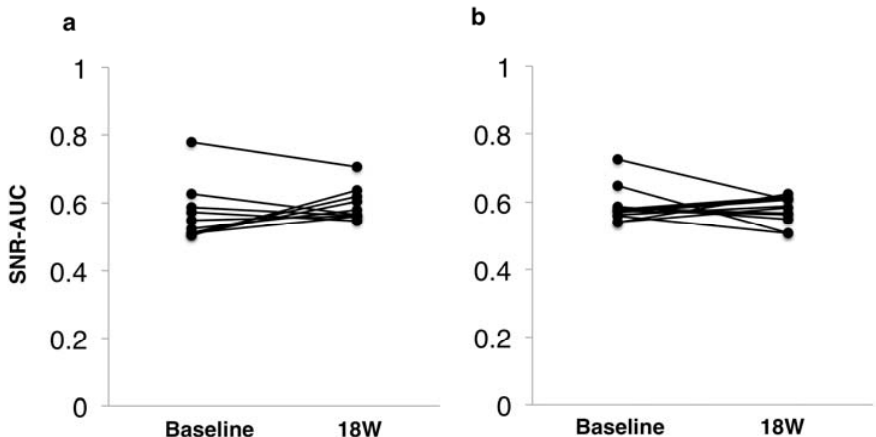
Figure 6. ROC analysis for multifocal visual evoked potentials from baseline to eight weeks after SES: ( a ) all 60 sectors showed no significant difference in SNR ‐ AUC ( p = 0.33); and ( b ) the central 36 sectors showed no significant difference in SNR ‐ AUC ( p = 0.54). ROC, receiver operating characteristic curve; SES, skin electrical stimulation; SNR ‐ AUC, signal ‐ to ‐ noise ratio of area under the curve.